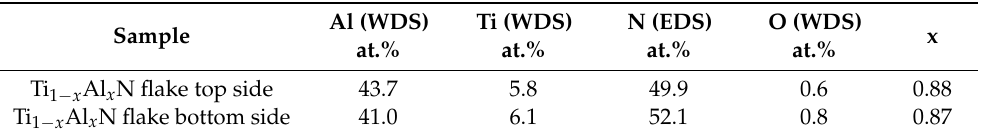
Table 1. Elemental analysis results on both sides of the flakes of the free-standing Ti 1 − x Al x N layer using WDS and EDS (flake surface was ion polished before elemental analysis) and calculated for stoichiometric coefficient x.